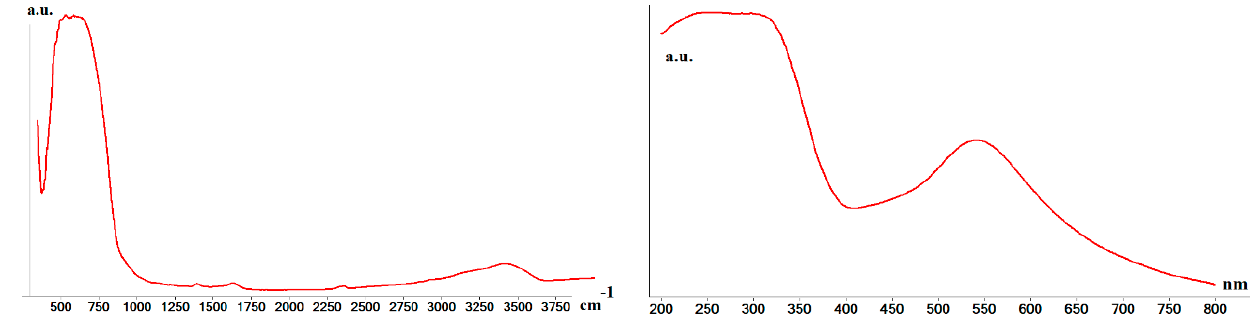
Figure 2. IR ( left ) and UV-Vis ( right ) spectra of the material.